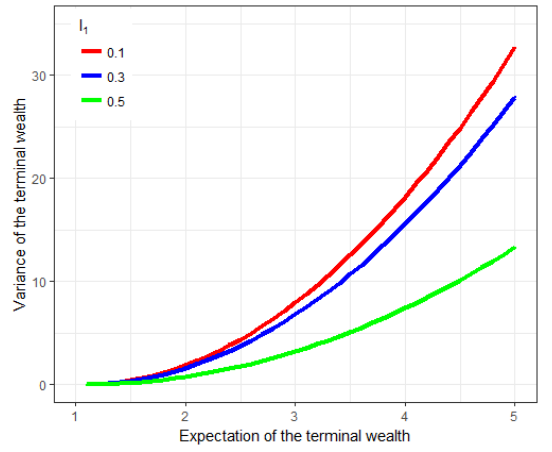
Figure 3. Effects of l 1 on the efficient